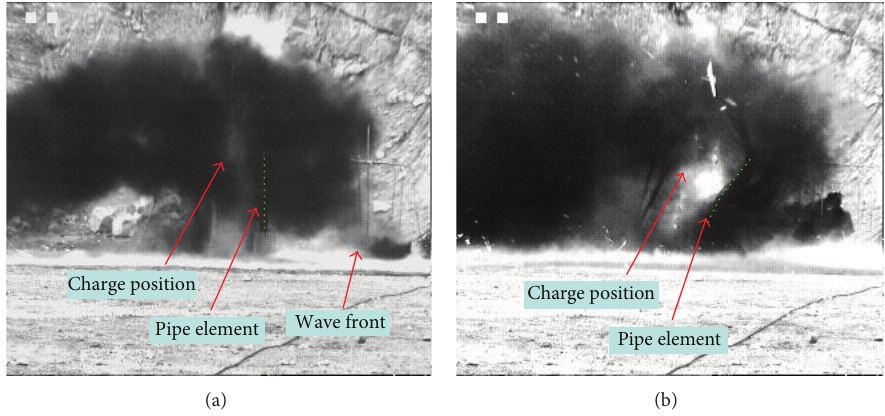
Figure 10: Acquired frames 2ms (a) and 20 ms (b) after the explosion in the third